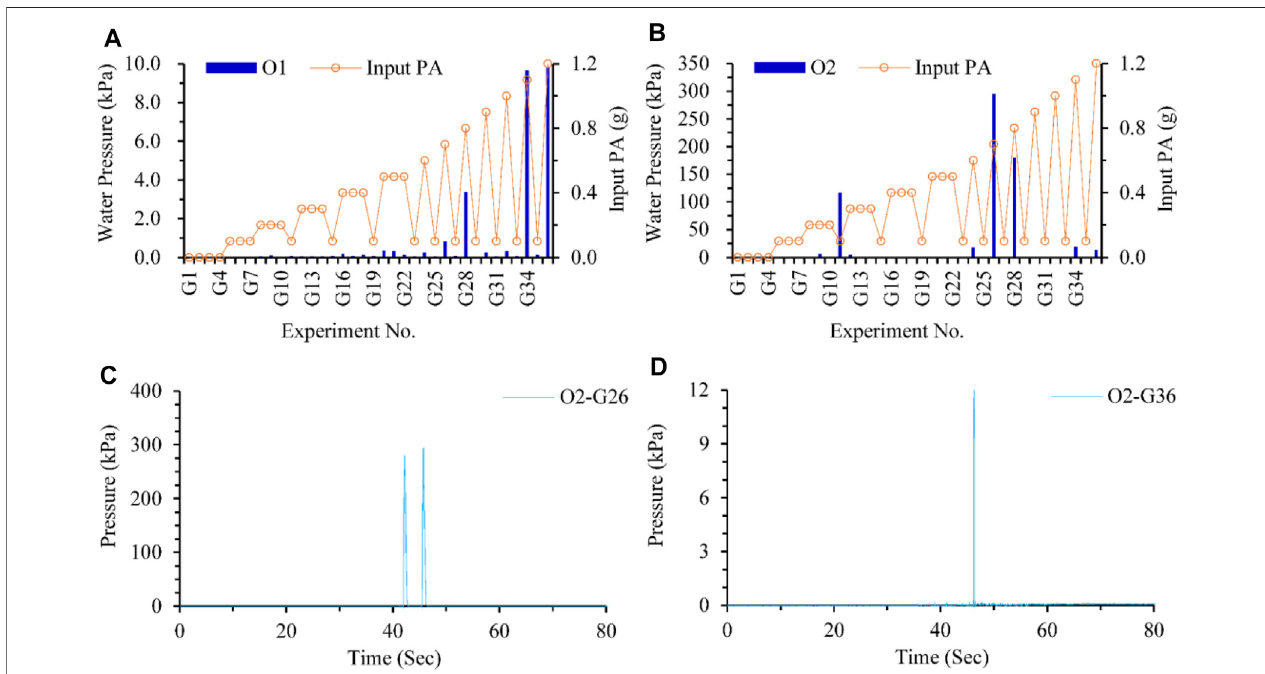
FIGURE19| Dynamic waterpressureresponseinsidethepipeline. (A) WaterpressureresponseofO1undervarious loadings. (B) Waterpressureresponse ofO2 under various loadings. (C) Water pressure response of O2 under G26. (D) Water pressure response of O2 under G36.